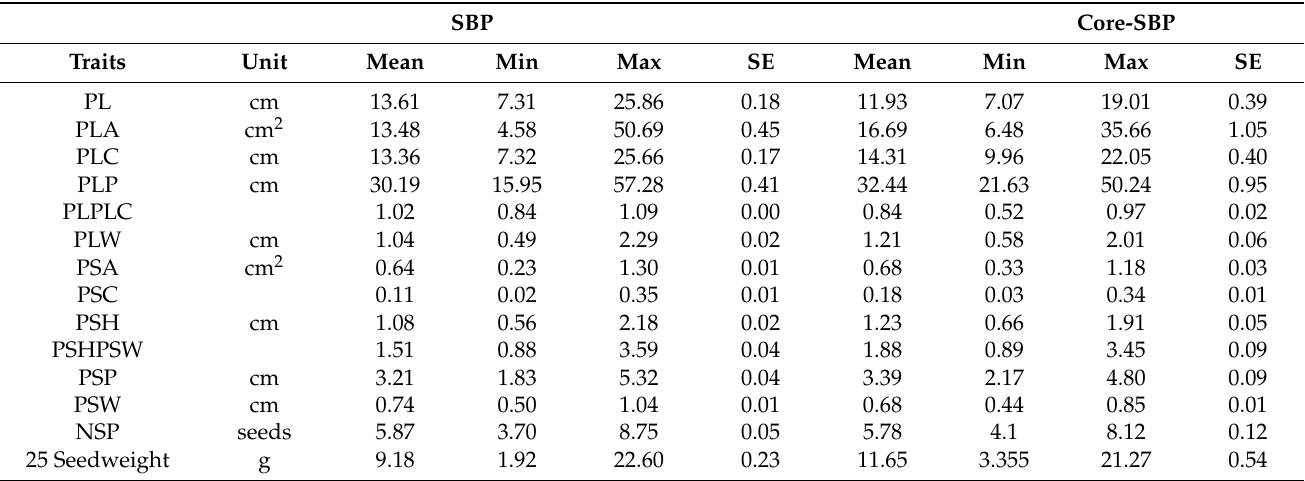
Table 2. Means, interval variation (Min, Max), and standard errors (SE) for the 14 quantitative pod traits recorded in the Snap Bean Panel (SBP) and core set established from this SBP (Core-SBP).